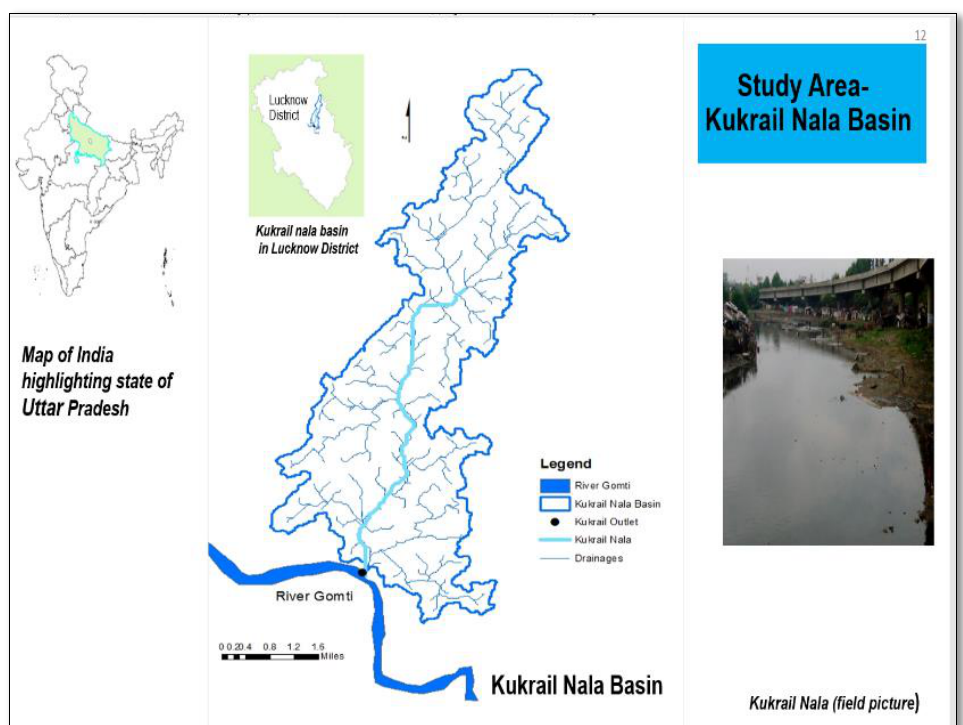
Figure 1. Location of Kukrail river basin inside Lucknow city, India.